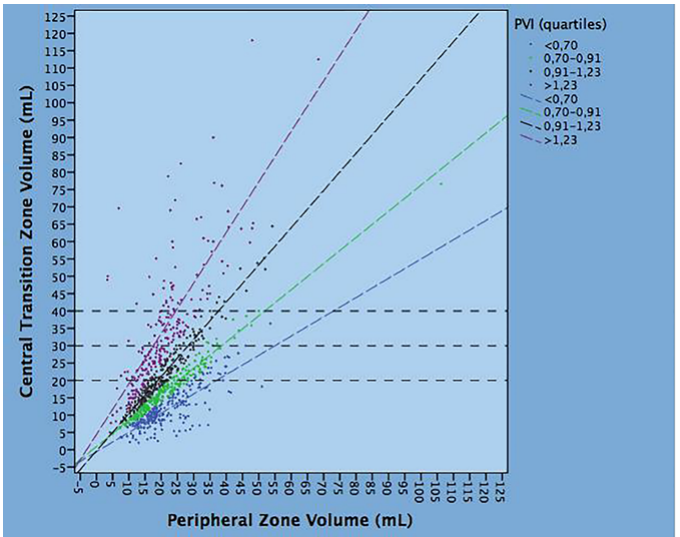
Figure 4 - The regression lines of the transitional zone volume (TZV) as a function of the peripheral zone volume (PZV). The patients are classified into 4 groups according to PVI quartiles. The different relations between volumes are outlined along different PVI